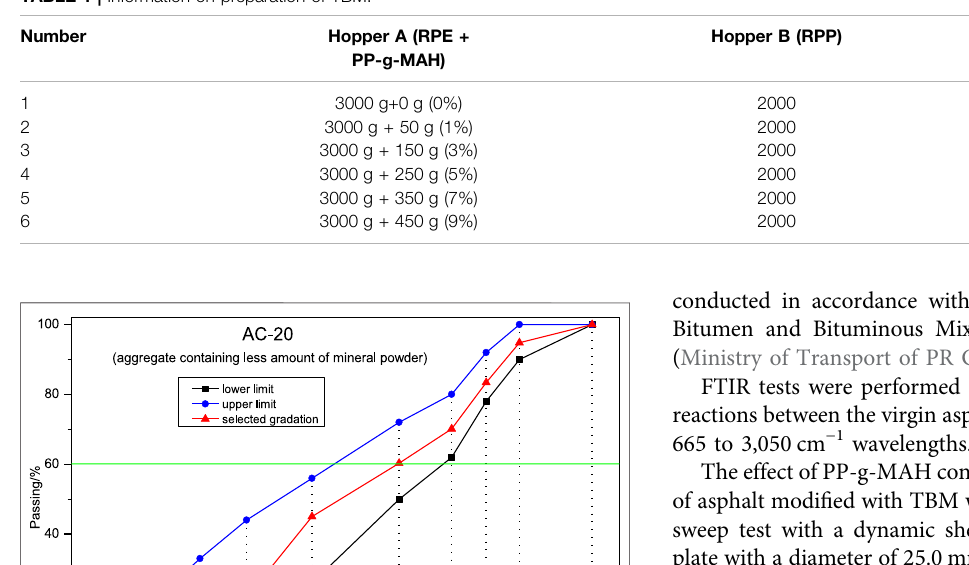
TABLE 1 | Information on preparation of TBM.